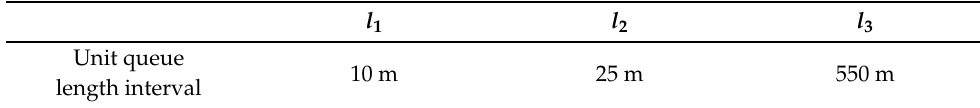
Table 7. Setting of unit queue length